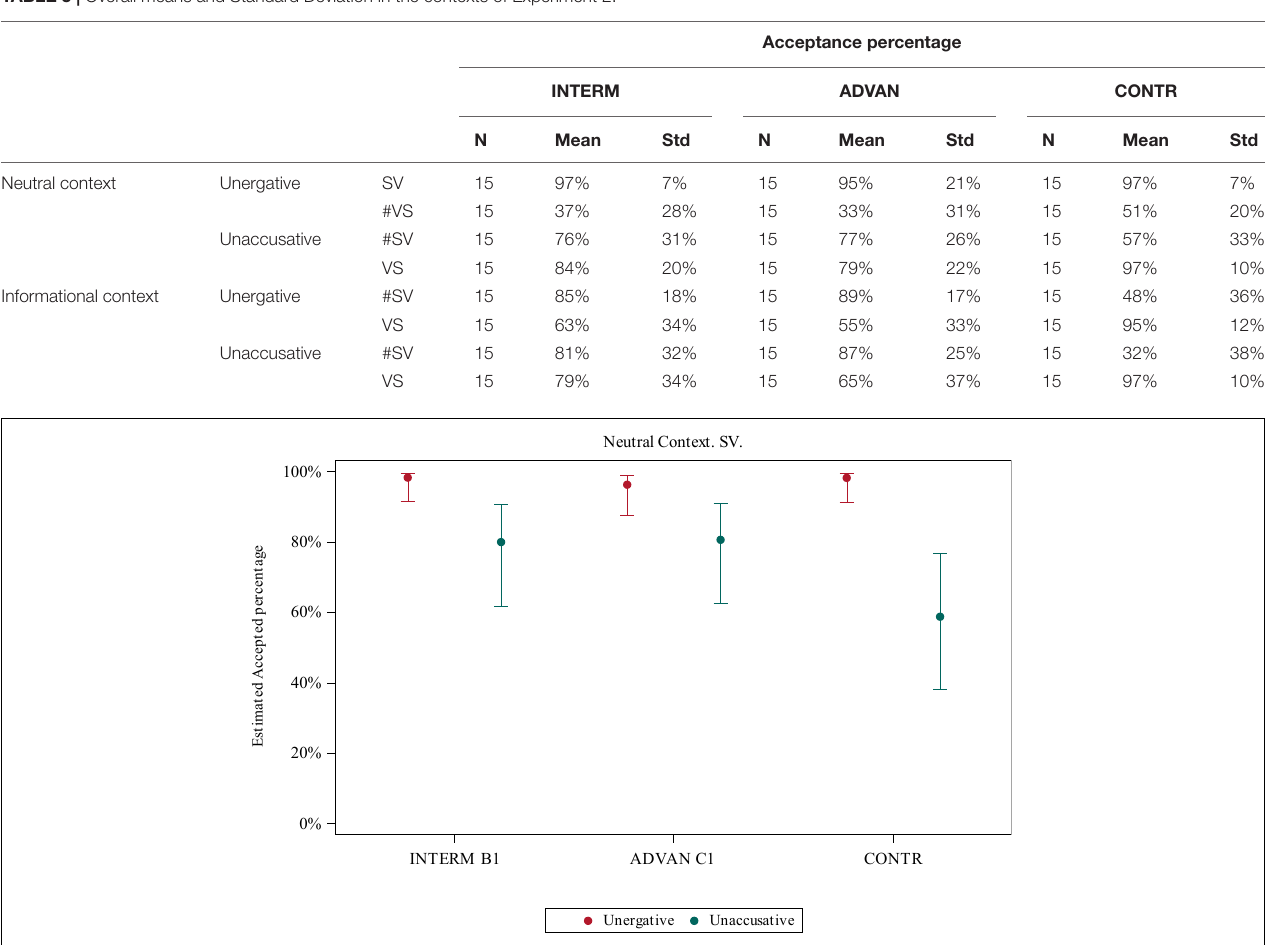
TABLE 3 | Overall means and Standard Deviation in the contexts of Experiment 2.